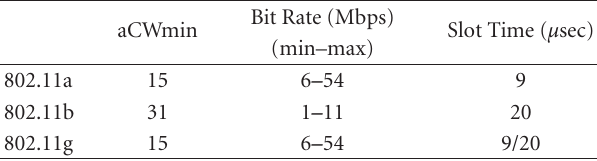
Figure 2: Successful beacon transmission rate of 802.11b. Table 1: Specifications of 802.11a/b/g.